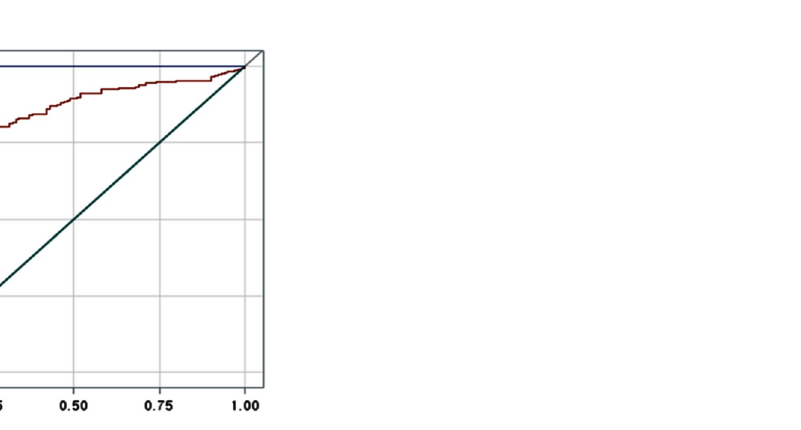
Figure 3. Receiver operating characteristic (ROC) curve for AhRT activity in 390 GDM and 100 non-GDM participants. The ROC curve determined the sensitivity and specificity of AhRT activity for GDM risk. The top and bottom lines in the ROC curves corresponded to GDM predictive tests. The top line represented serum glucose concentration from a 50 g glucose challenge for GDM prediction, and its area under the curve (AUC) was 0.9993. The bottom line indicated AhRT bioactivity to GDM prediction, and its AUC was 0.8527. These results indicated the AhRT bioactivity could be considered as a GDM risk factor. ROC2 was the